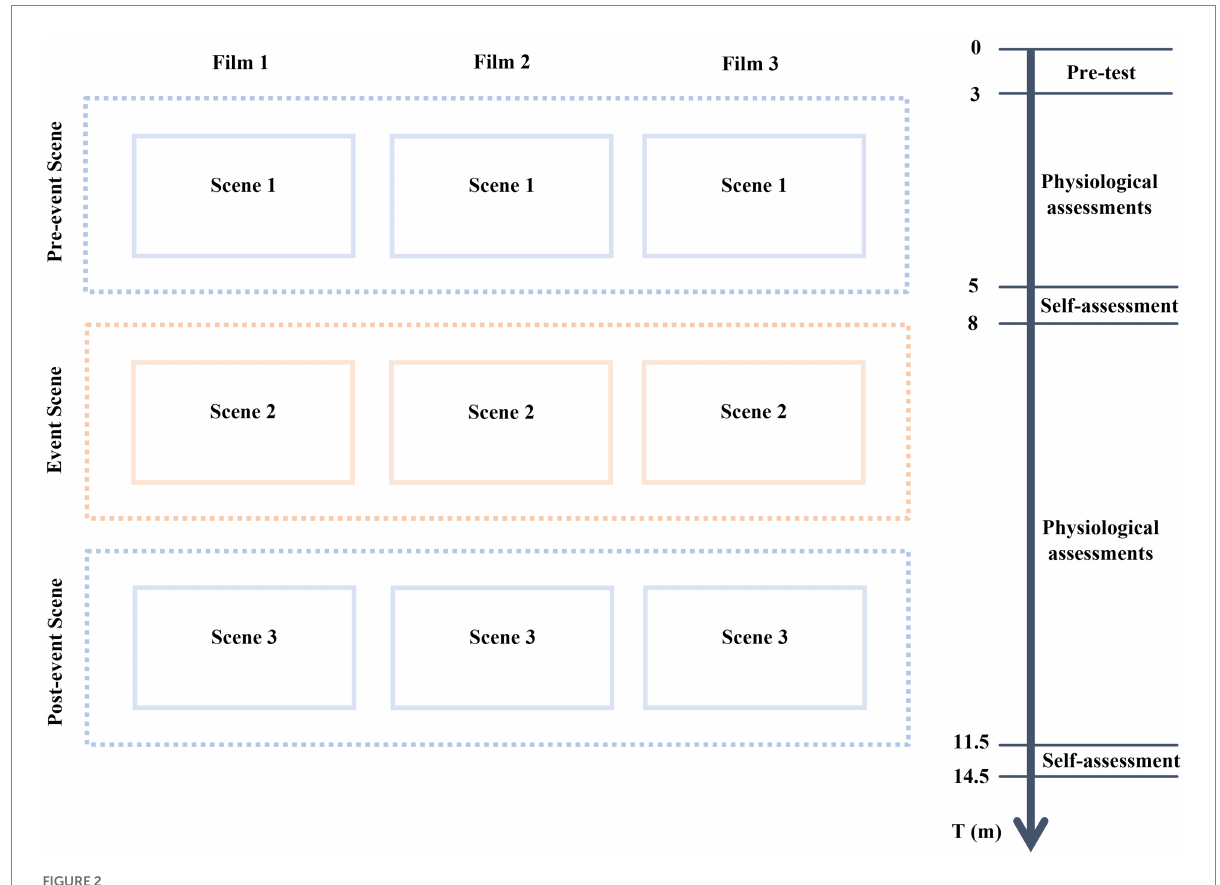
FIGURE 2 Research